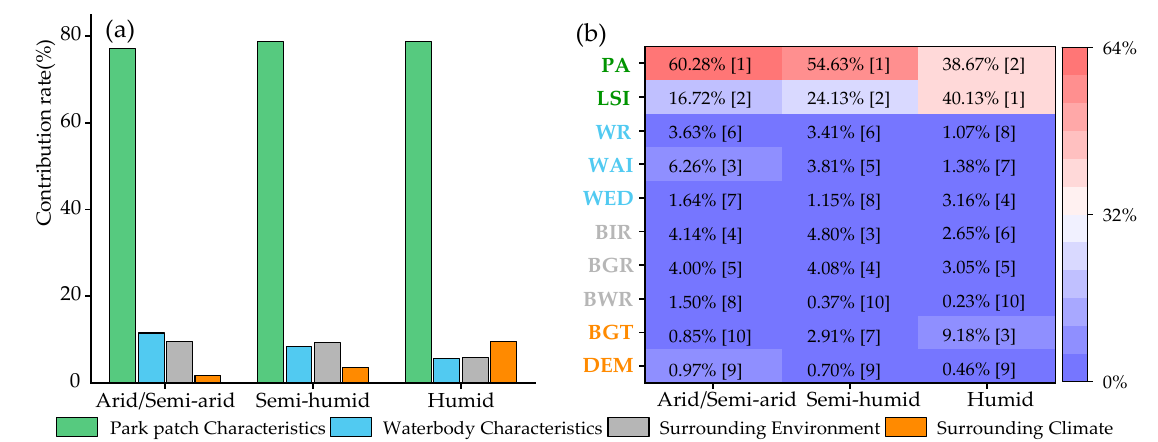
Figure 7. Contribution rate of influencing factors of park cooling area: ( a ) is the total contribution rate of the four categories, ( b ) is the individual contribution rate of 10 impact factors, [] is the importance ranking of impact